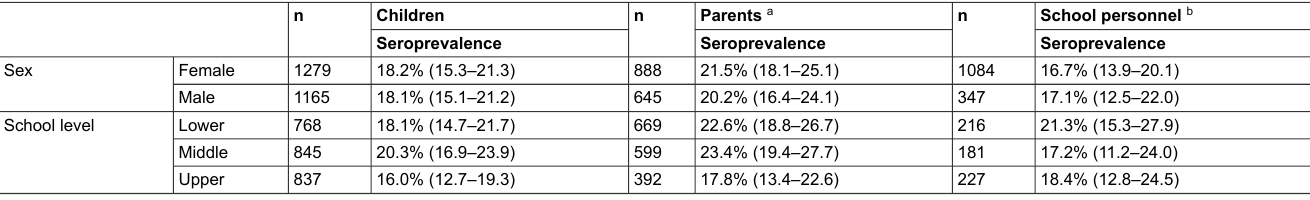
Table 2: Seroprevalence with 95% confidence interval in children, parents and school personnel based on sex and school level in March-April